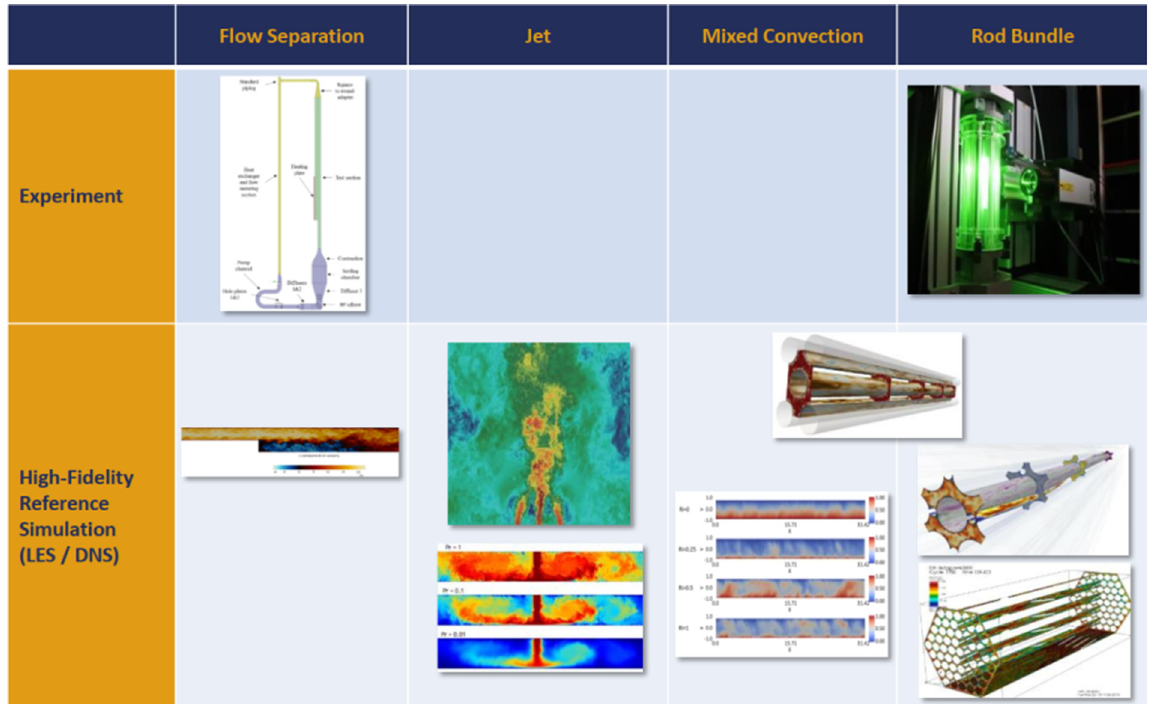
Fig. 3. Overview of reference data referred to liquid metal heat